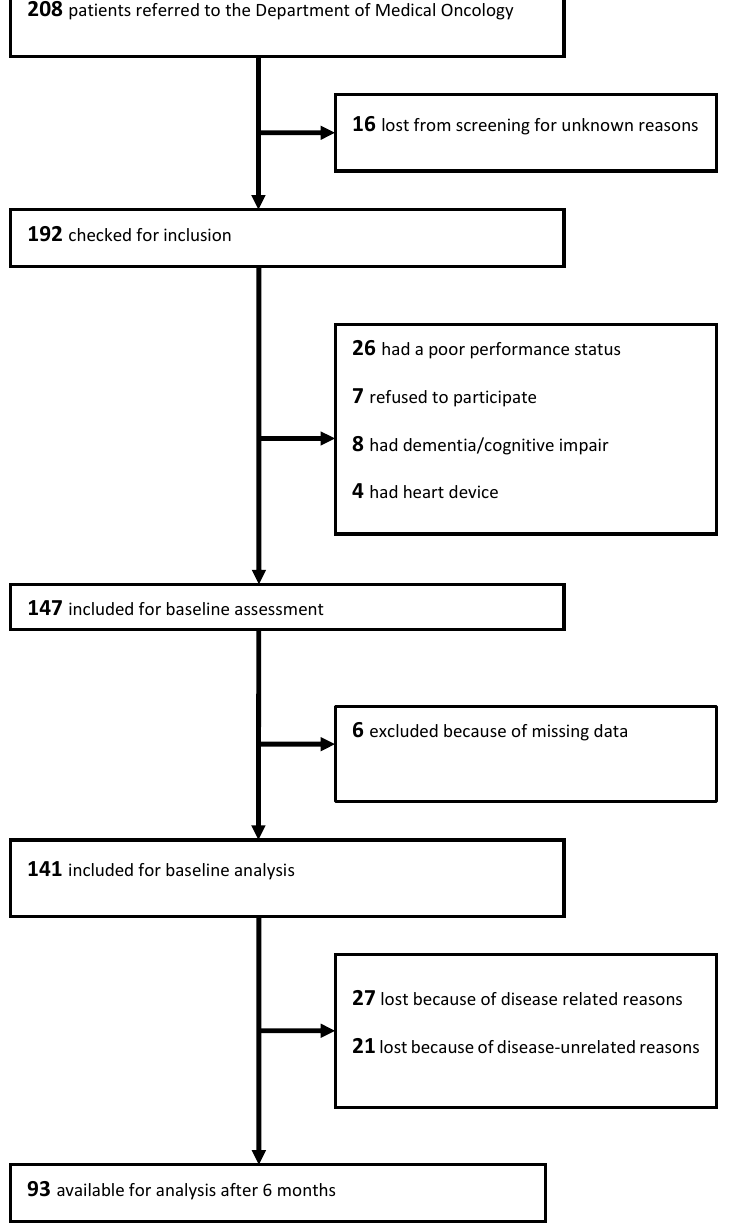
Figure 2. Flow chart of patients included into the study. Table 1. Systemic treatment according to the line and type of therapy in each nutritional sub- group.